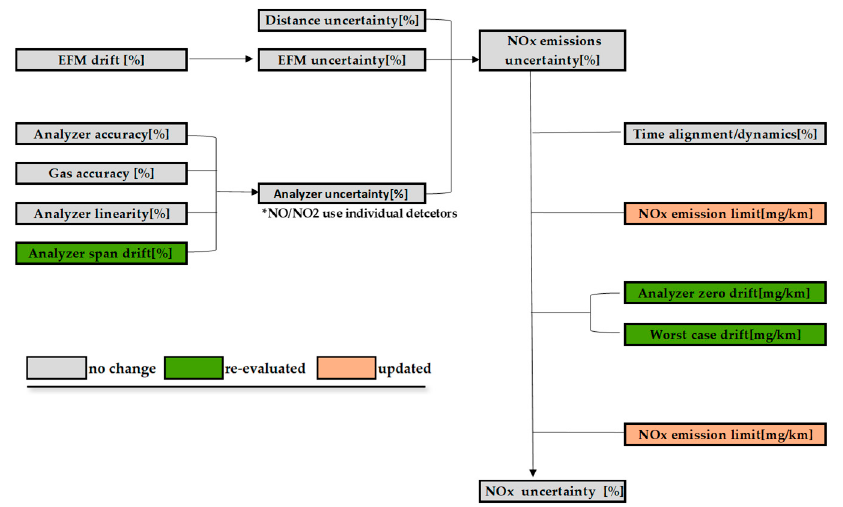
Figure 1. EU uncertainty calculation scheme with CVS uncertainty excluded.